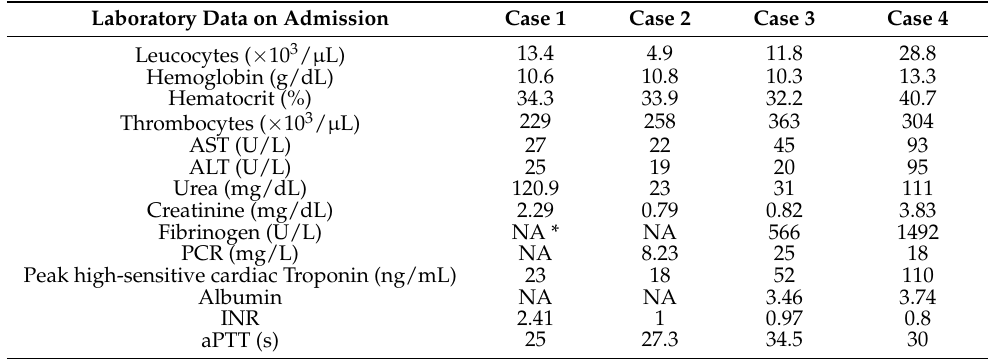
Table A1. Laboratory data on admission.